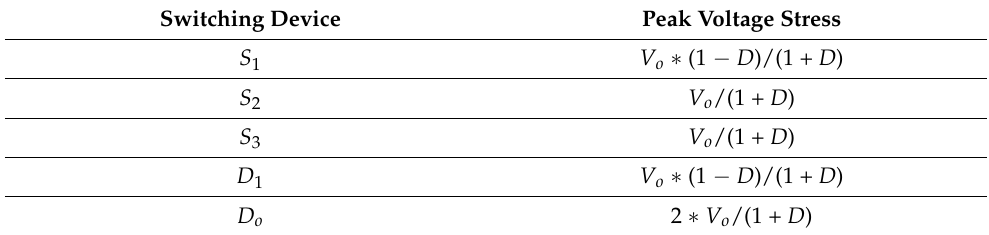
Table 1. The voltage stresses of the switching devices.